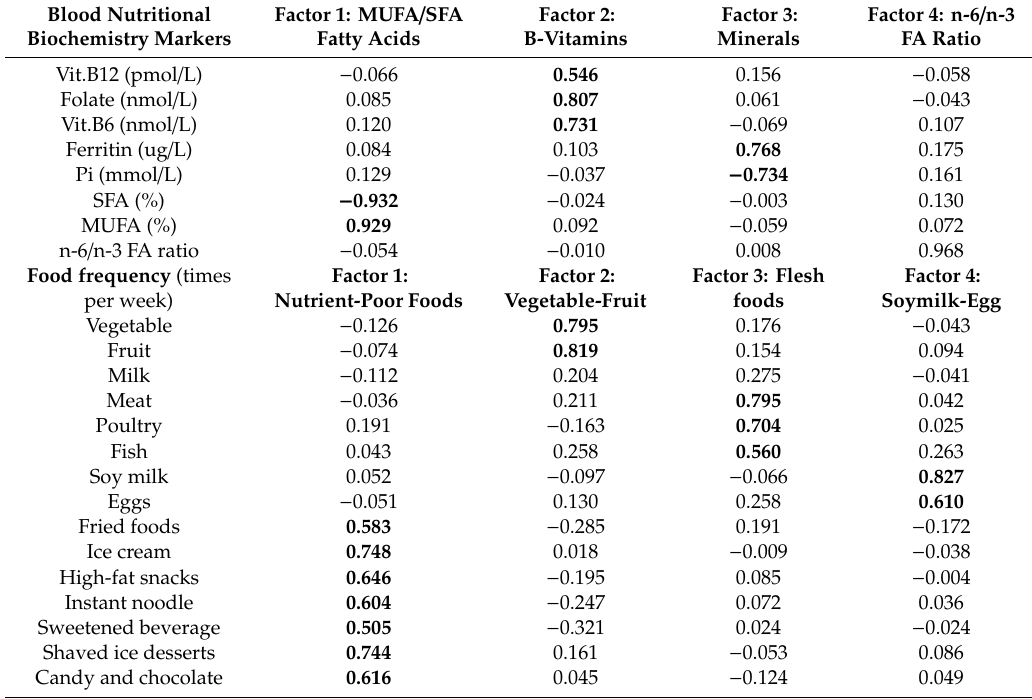
Table 2. Principal components identified from blood nutritional biochemistry markers and from food frequency a,b and factor loading scores of the studied variables.